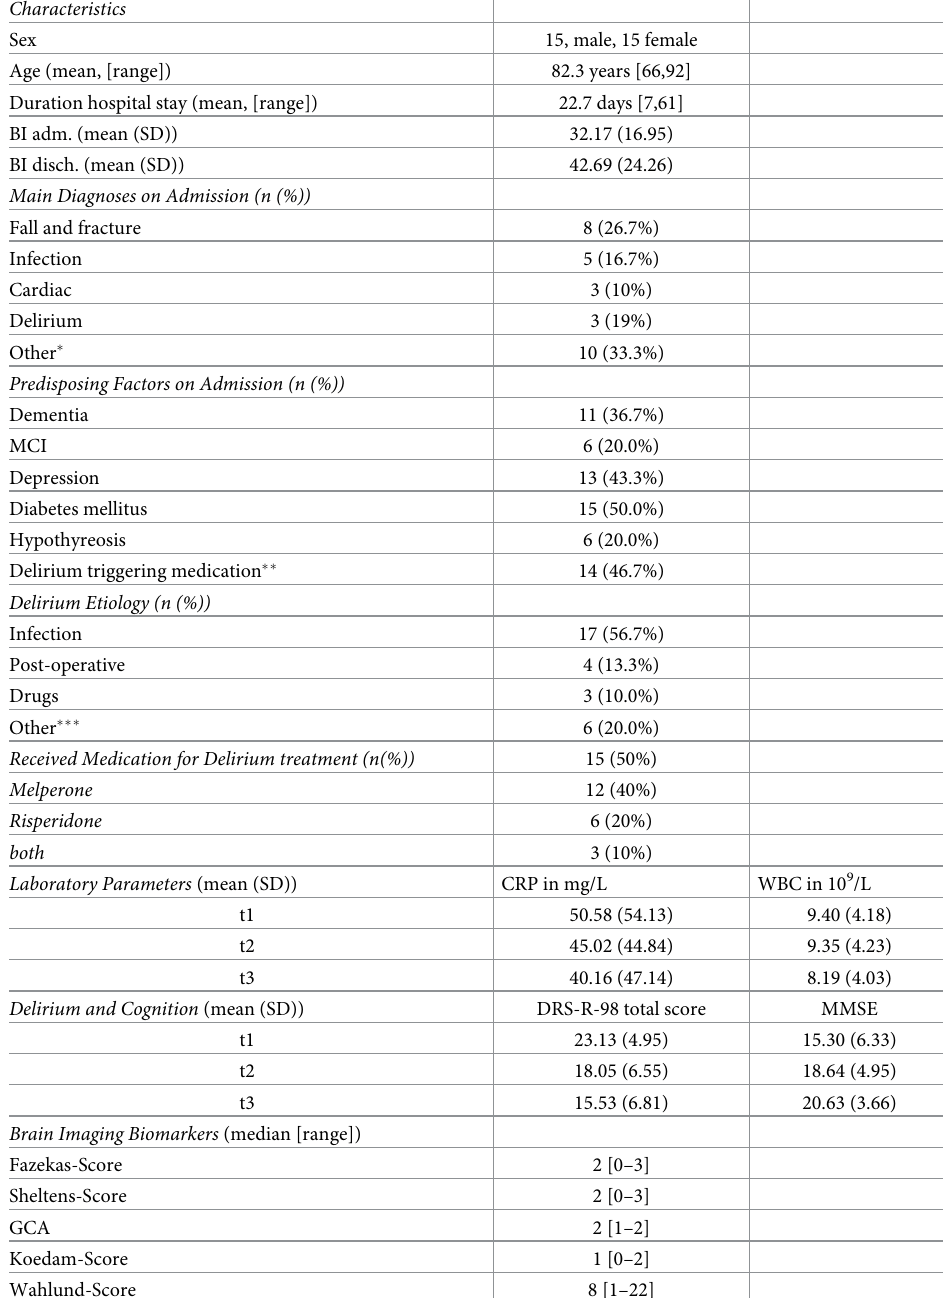
Table 1. Demographic and clinical characteristics of the